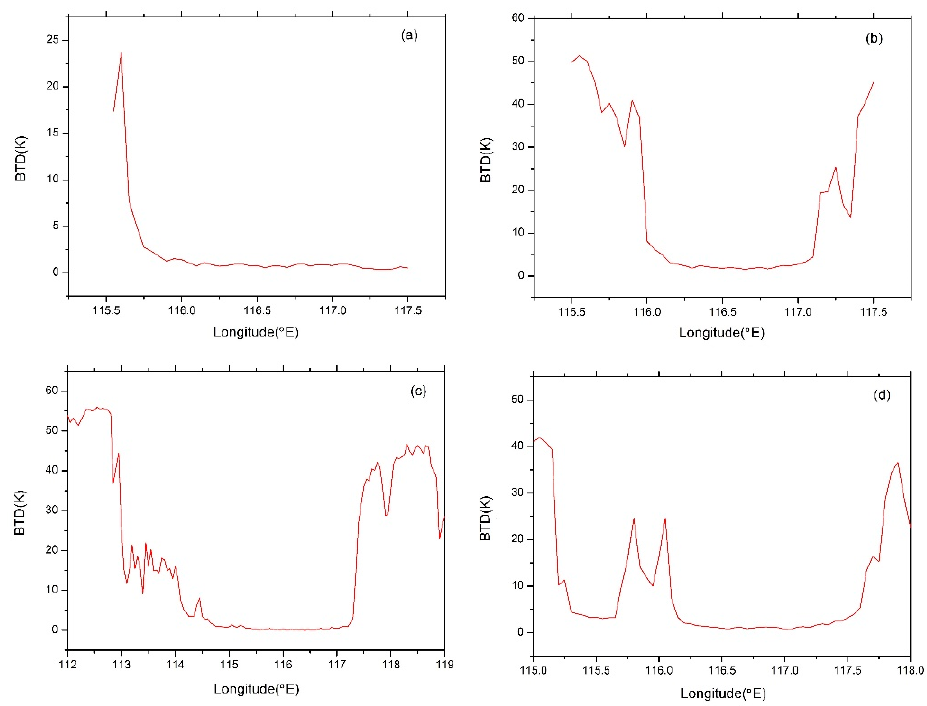
Figure 11. Brightness temperature difference (BTD) distribution along transects (40.5°N) crossing the main core of the hailstorm in the longitudinal direction for the analyzed case studies. ( a ) BTD on 25 June 2021; ( b ) BTD on 30 June 2021; ( c ) BTD on 1 July 2021; ( d ) BTD on 9 August 2021.